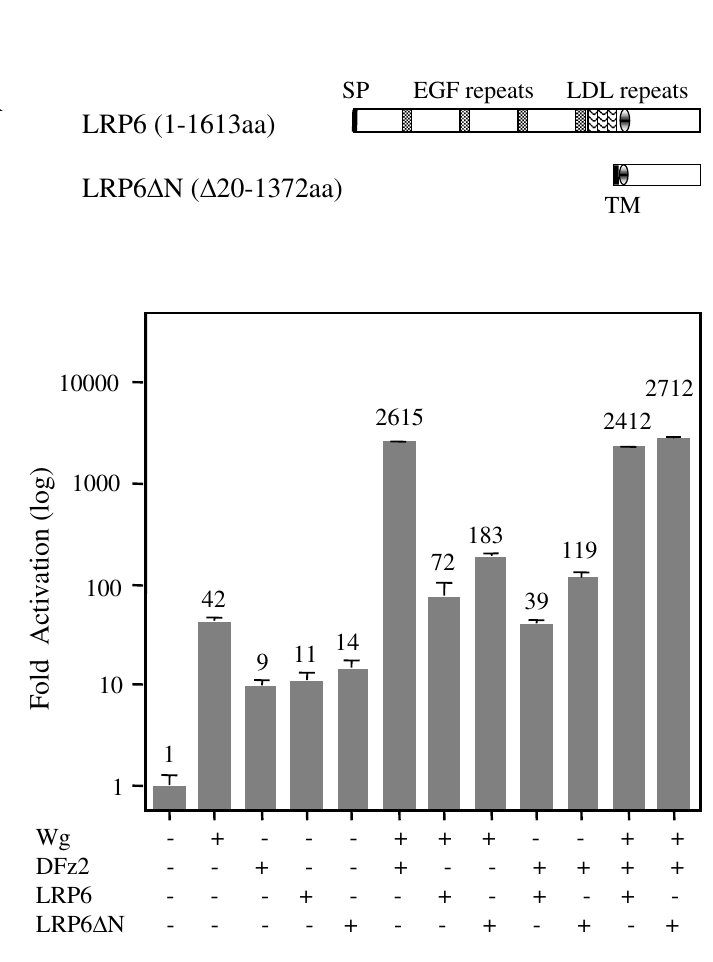
LRP6 and LRP6 ∆ N stimulate the signaling pathway. (A) Diagram of the full-length LRP6 and its truncated construct LRP6 ∆ N with deleted aminoterminus. SP represents the signal peptide and TM denotes the transmembrane domain. (B) S2 cells were transfected with the indicated expression plasmids. Fold activation values were measured relative to the levels of luciferase activity in cells transfected with empty vectors and normalized by Renilla luciferase activities. These values are plotted as a log function. All experiments were done in triplicate; error bars represent the standard